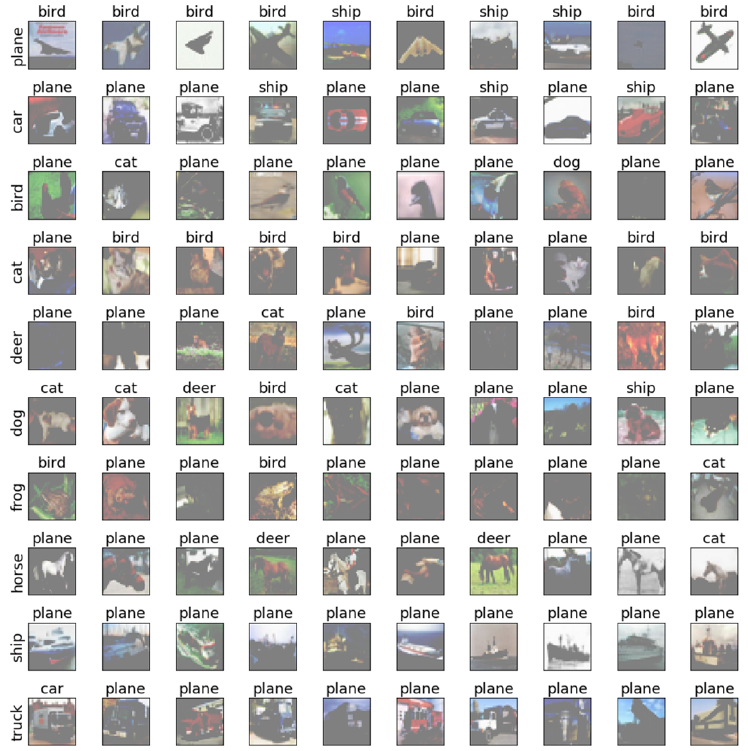
Figure 10. The adversarial examples of CW for Cifar10 and AlexNet.